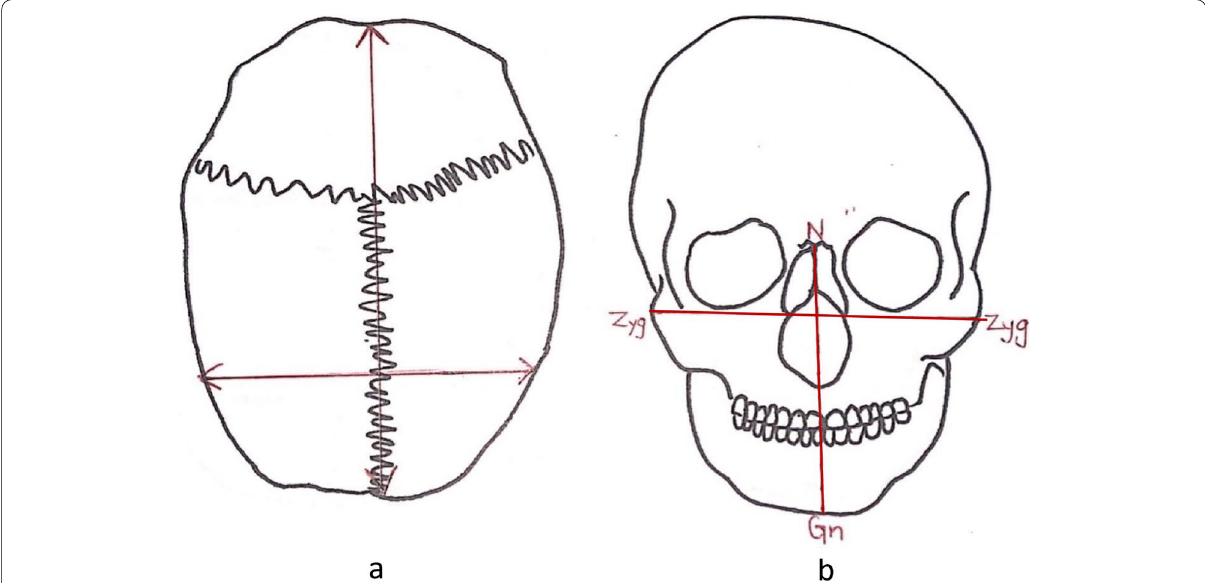
Fig. 5 Cephalic and facial index (Franco et al. 2013). a Maximum skull width/ length. b Nasion-Gnathion/ Bizygomatic width